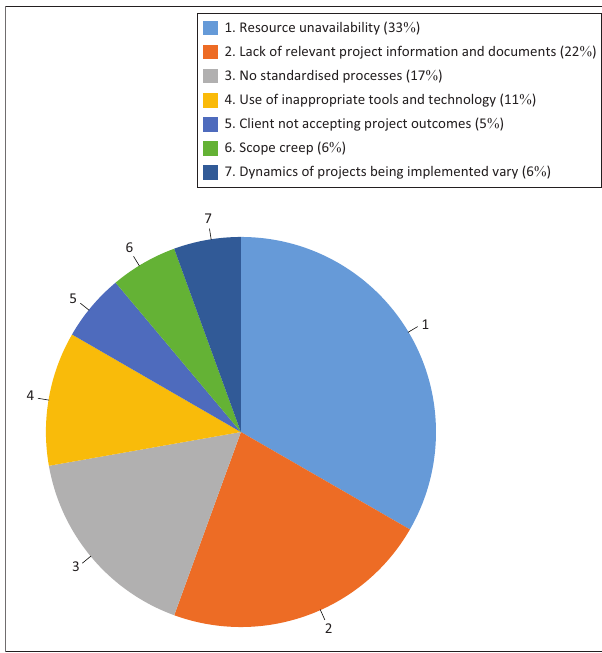
FIGURE 4: Challenges related to benefits realisation